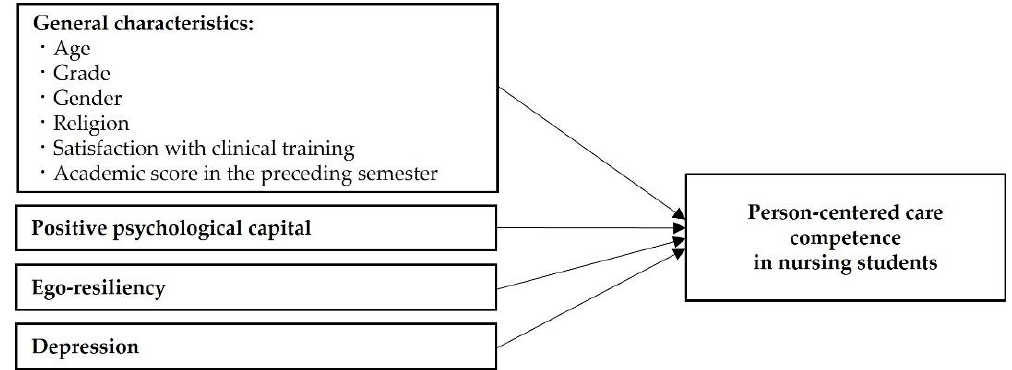
Figure 1. Conceptual framework for this study.